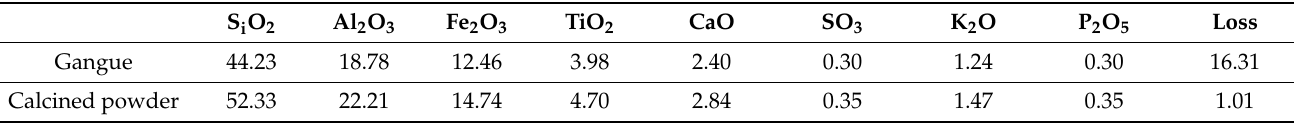
Table 1. Composition analysis of gangue and its calcined